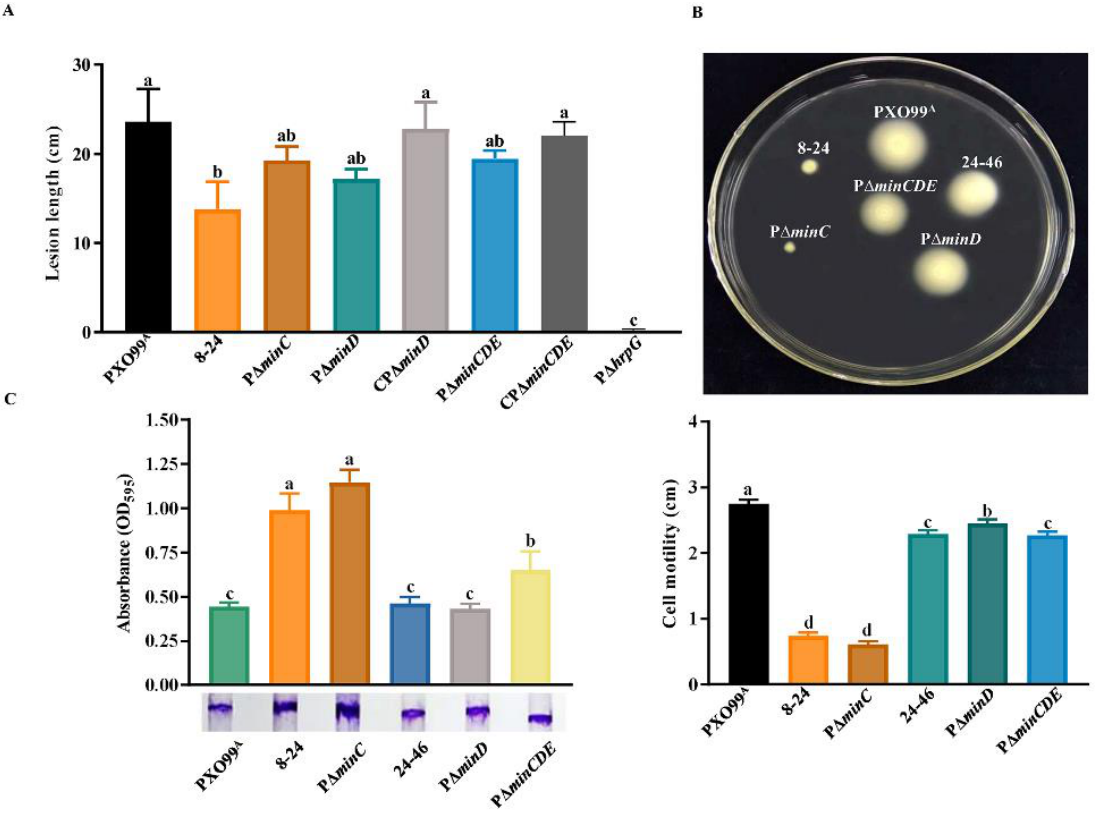
Figure 5. MinC affects Xoo virulence, biofilm formation, and swimming motility. ( A ) Lesion lengths of the leaves of IR24 caused by Xoo wild-type PXO99 A , 8–24, P ∆ minC , P ∆ minD , CP ∆ minD , P ∆ minCDE , CP ∆ minCDE , and P ∆ hrpG at 14 days post-inoculation by leaf-clipping. Bacterial sus- pensions (OD 600 = 0.6) were inoculated in the leaves of susceptible rice IR24. P ∆ hrpG as a negative control strain without pathogenicity on rice. Similar results were observed in two independent experiments. ( B ) Swimming motility of PXO99 A , 8–24, P ∆ minC , 24–46, P ∆ minD , and CP ∆ minD on NA medium with 0.15% agar. Swimming zones were measured and evaluated after bacterial growth on the NA plates for 3 days. As assessed by Duncan’s test, different letters indicate statistically significant differences ( p < 0.05) between Xoo strains. ( C ) Biofilm formation of PXO99 A , 8–24, P ∆ minC , 24–46, P ∆ minD , and P ∆ minCDE on glass test tube surfaces after 3 days of incubation The biofilm formation was visualized by crystal violet staining, then was quantified by measuring the absorbance at 590 nm. The tests were repeated three times. As assessed by Duncan’s test, different letters indicate statistically significant differences ( p < 0.05) between Xoo